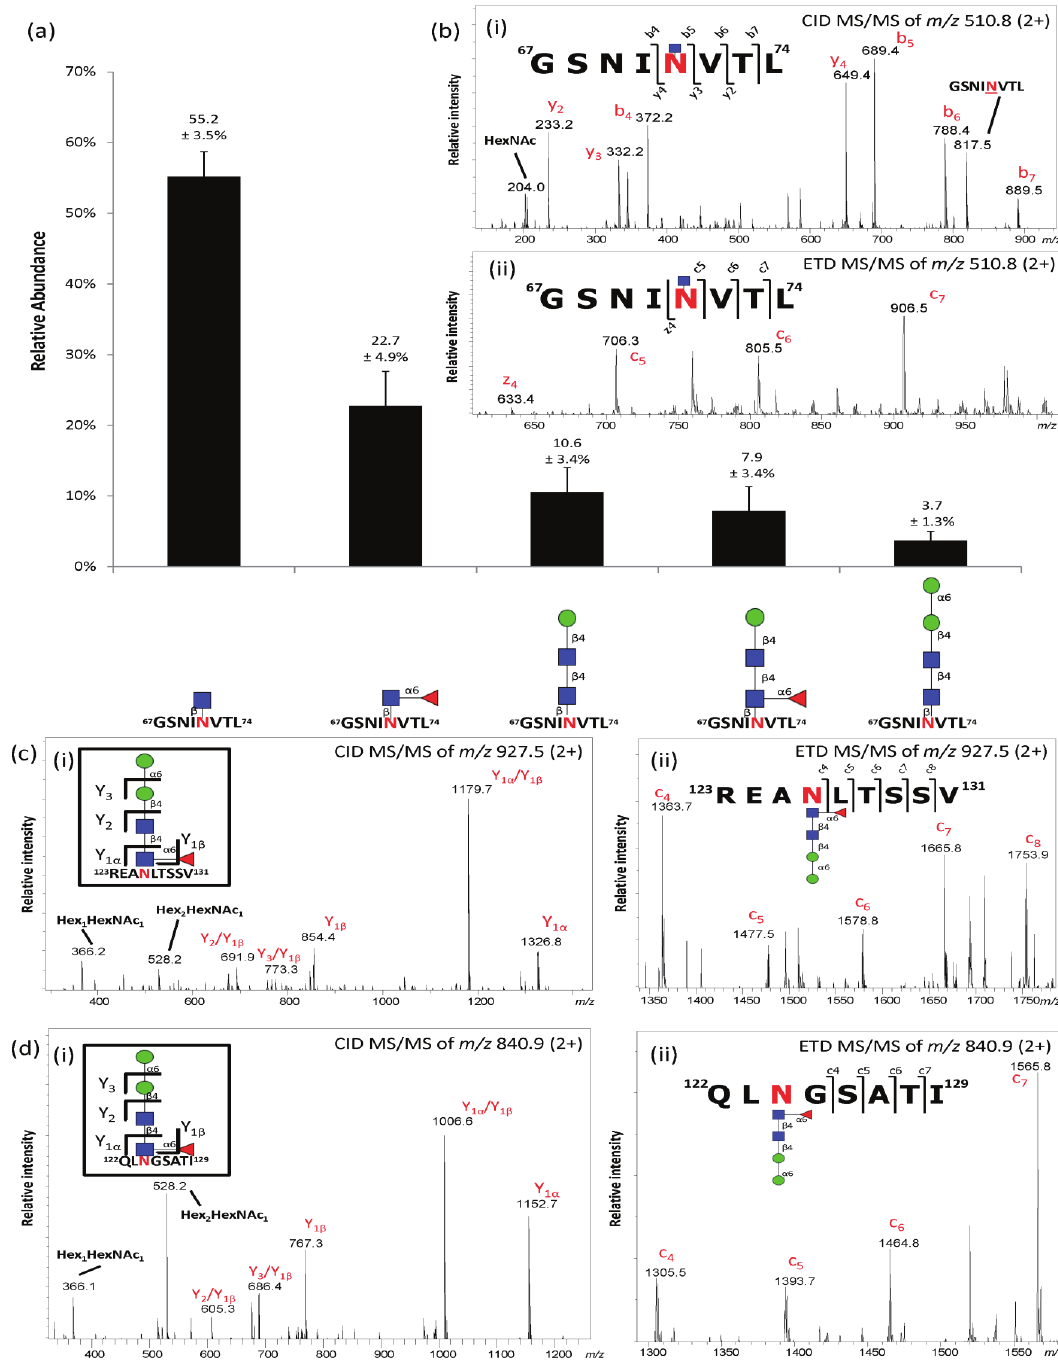
Figure 3. ( a ) Profiling of unenriched chymotryptic Asn71-glycopeptides derived from nCG in positive ionization polarity. Data points are plotted as mean ± SD, n = 3; ( b ) (i) CID-and (ii) ETD-MS/MS of the predominant chymotryptic GlcNAc(cid:2)Asn71-glycopeptide variant (GSNI N VTL); ( c , d ) (i) CID- and (ii) ETD-MS/MS of the chymotryptic M2F-containing N -glycopeptide originating from the interfering neutrophil proteins i.e. , ( c ) azurocidin and ( d ) NE covering the N -glycosylation sites Asn126 and Asn124, respectively. See Figure S4 for glycopeptides covering other observed sites of azurocidin and NE. See also Table 1 for summary of all observed glycoforms of the three N -glycoproteins identified in the protein